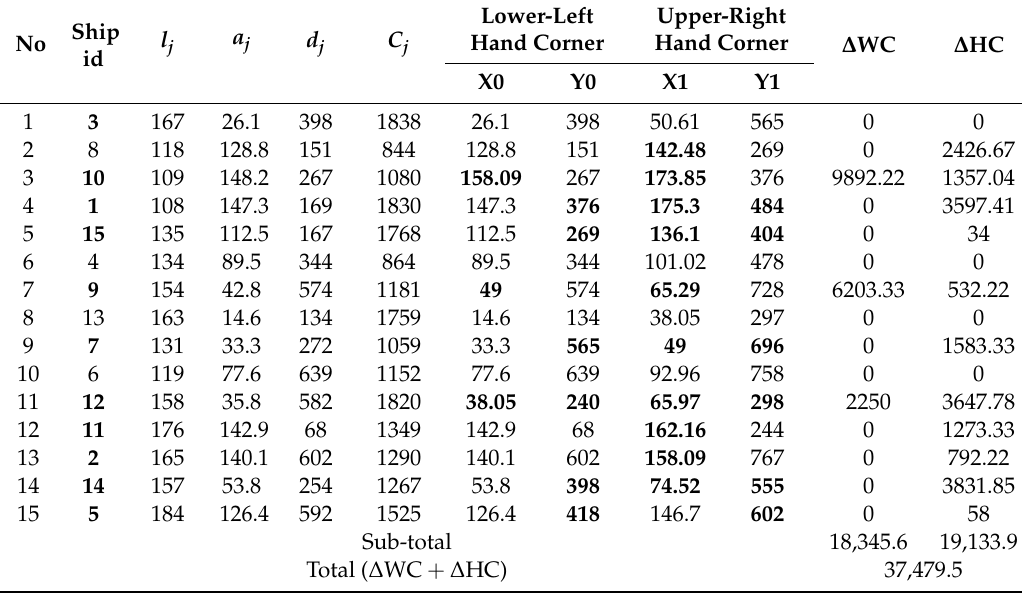
Table 4. The coordinates of the calling ships ( N = 15) after resolving overlaps of